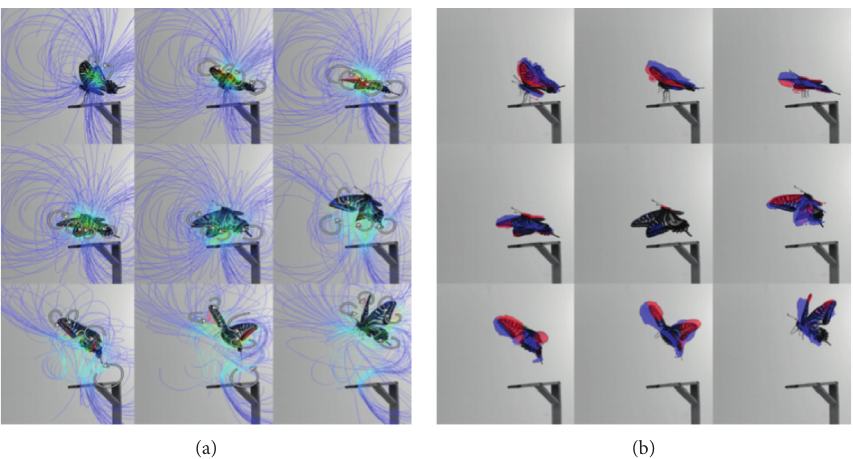
Figure 8: Stroboscopic image pitch rotational flight picture from